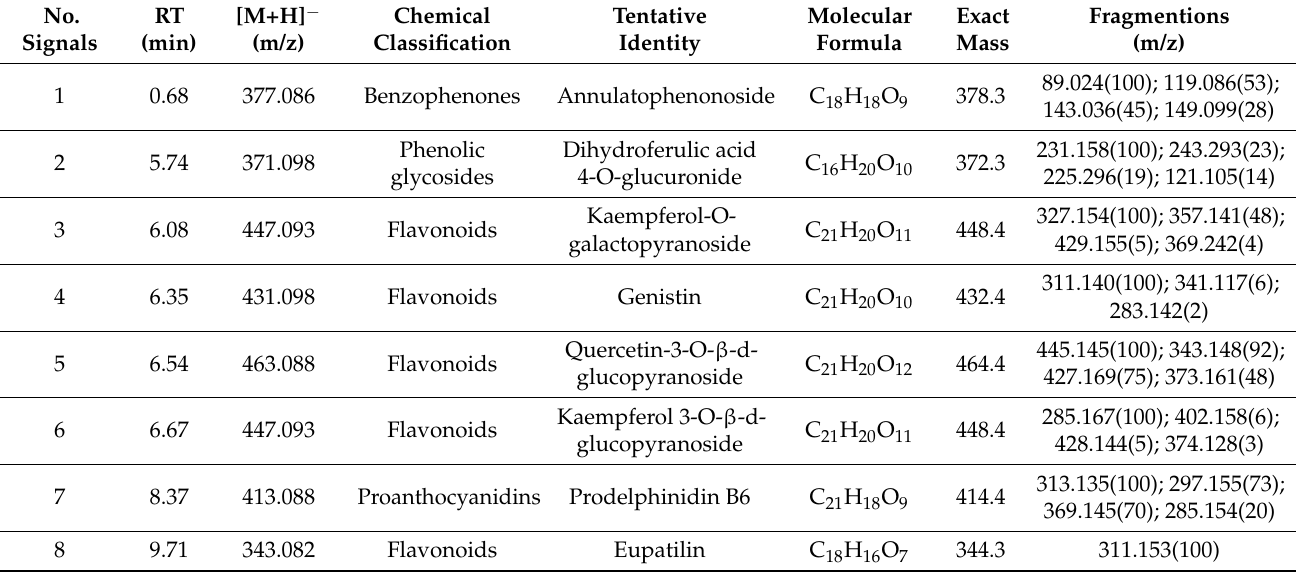
Table 6. Phytocompounds in E-Anvi extract from A. virginicus detected by